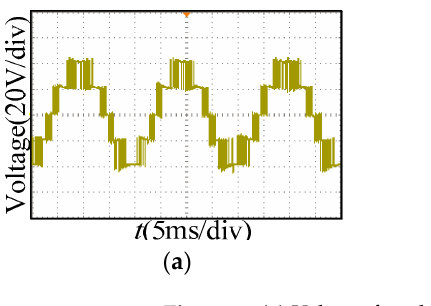
Figure 8. ( a ) Voltage for phase A. ( b ) Current for phase